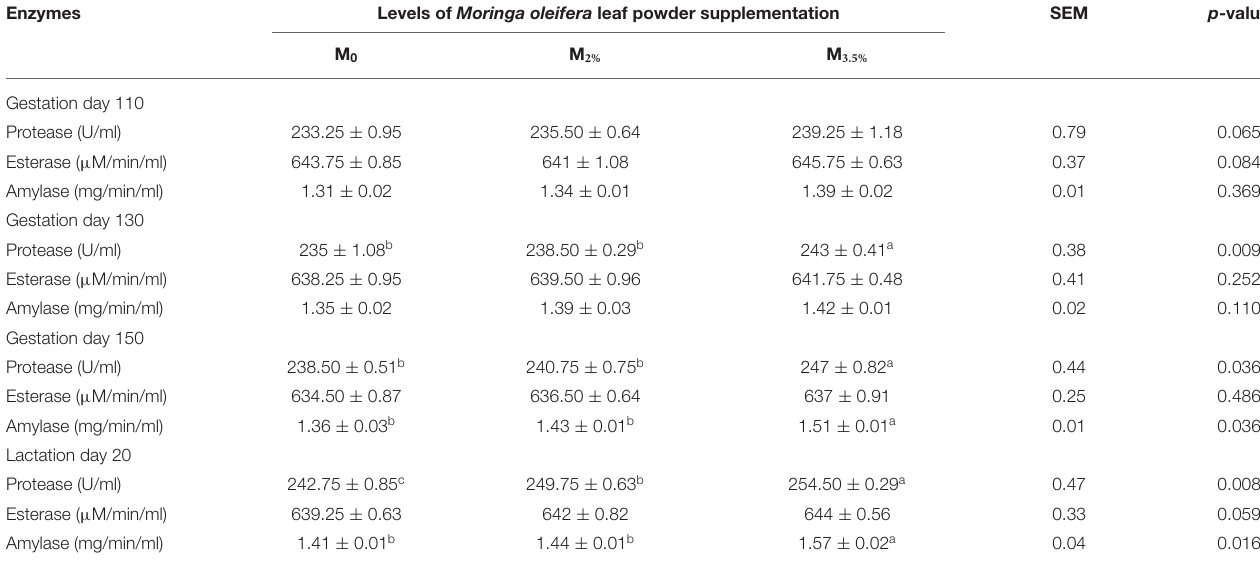
TABLE 7 | Plasma hydrolytic enzymes activities of Beetal goats. Enzymes